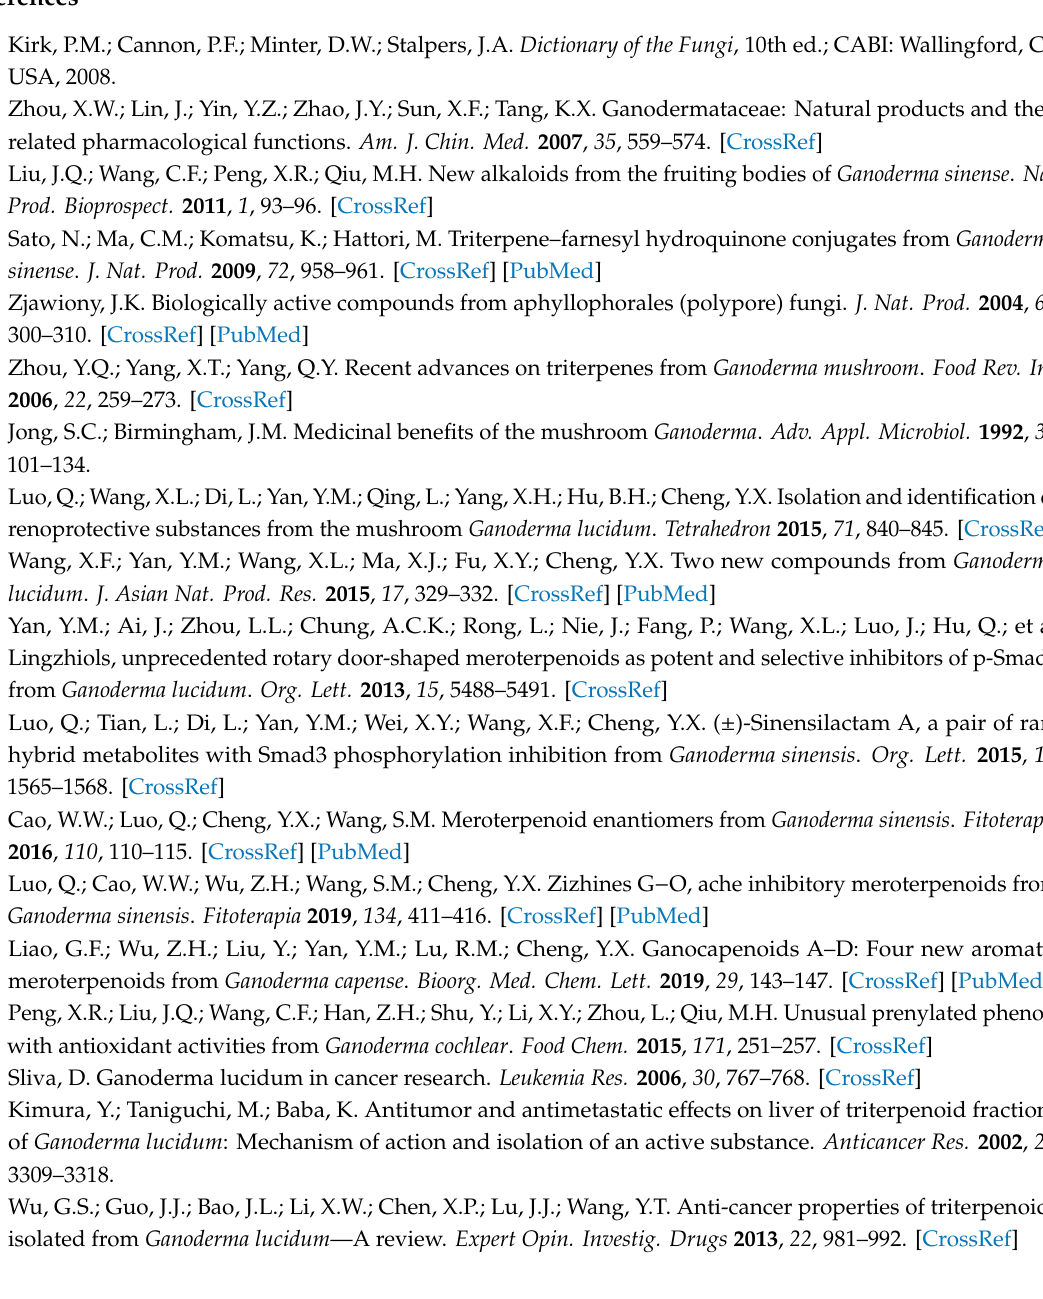
NMR spectra and HRESIMS of 7 , Figure S60: The lowest energy conformers of 1 , Figure S61: The calculated and experimental ECD spectra of 1 and 2 , Figure S62: The calculated model compounds 5c and 6c , Figure S63: The calculated and the experimental ECD spectra of 5 and 6 , Figure S64: Cytotoxic e ff ects of 4 , 5 , 6 and 5-FU on human cancer cells and normal cells Cells, Table S1: Extracted heats and weighting factors of the optimized conformers of 1 , Table S2: The Cartesian coordinates of the lowest energy conformers for 1 , Table S3: Standard orientation of 5c in MeOH, Table S4: Standard orientation of 6c in